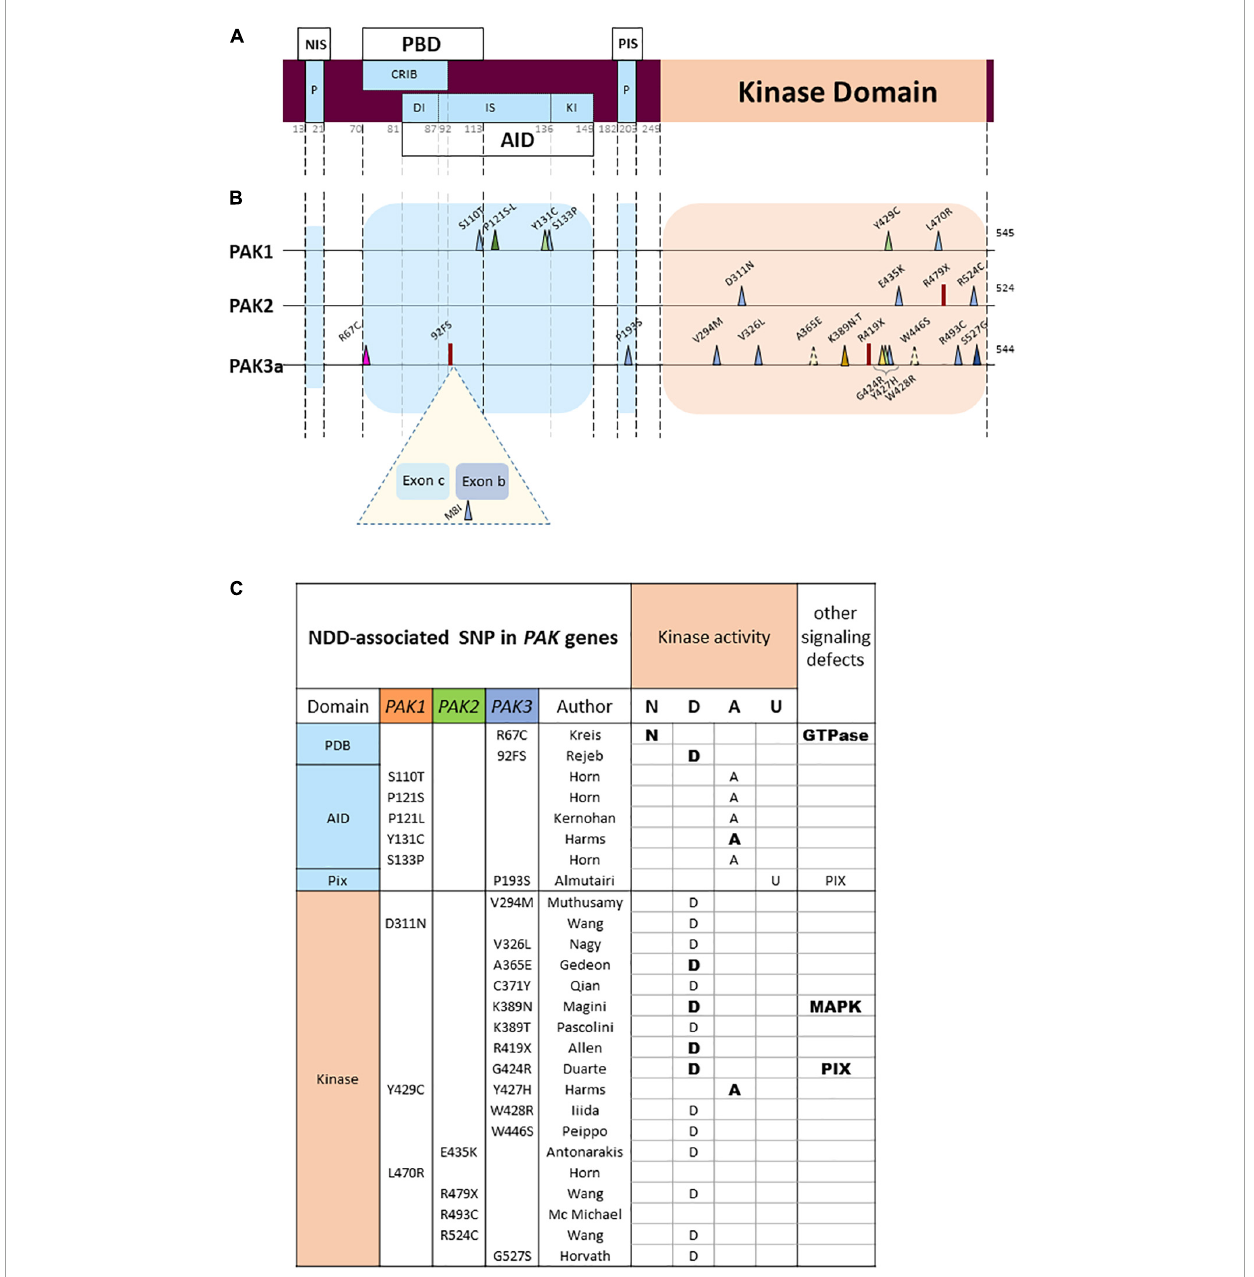
FIGURE3 PAK general structure and localization of variants (A) Domain structure of PAKs. NIS, Nck interacting sequences; P, praline-rich sequences; PBD, p21 binding domain; AID, auto-inhibitory domain; DI, Dimerization segment; IS, Inhibitory switch domain; Kl, kinase inhibitory segment; PIS, PIX interacting sequences. Numbering of the general structure is based on PAK 1. (B) Location of missense and LGD (likely gene disruptive) variations. Darker colors represent reccurrences. Both PAK3 alternative exons are represented (Exon b: 15 amino-acids; exon c: 21 amino-acids). (C) Validated or hypothetical functional alterations of PAK variants. N: normal kinase activity; D: defective; A: activated; U: unknown. Bold: experimentally validated; normal: